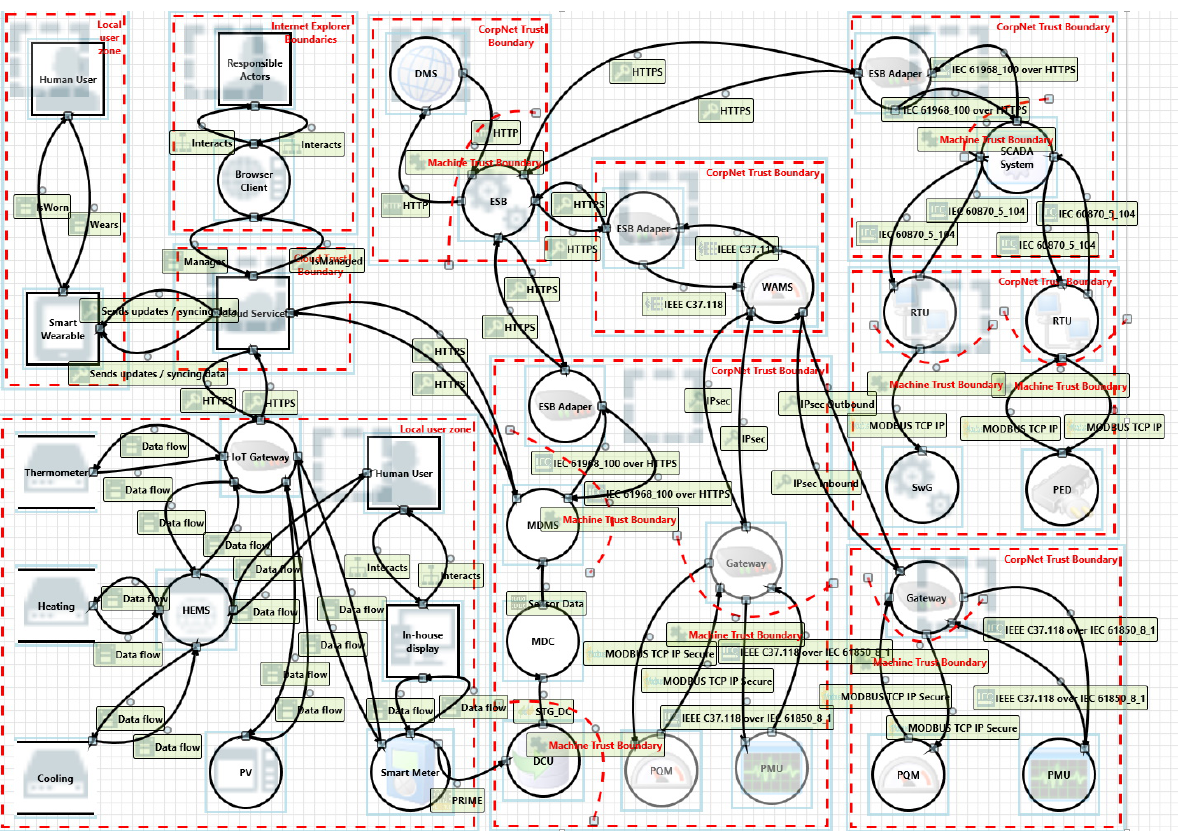
Figure 3. Threat Model.